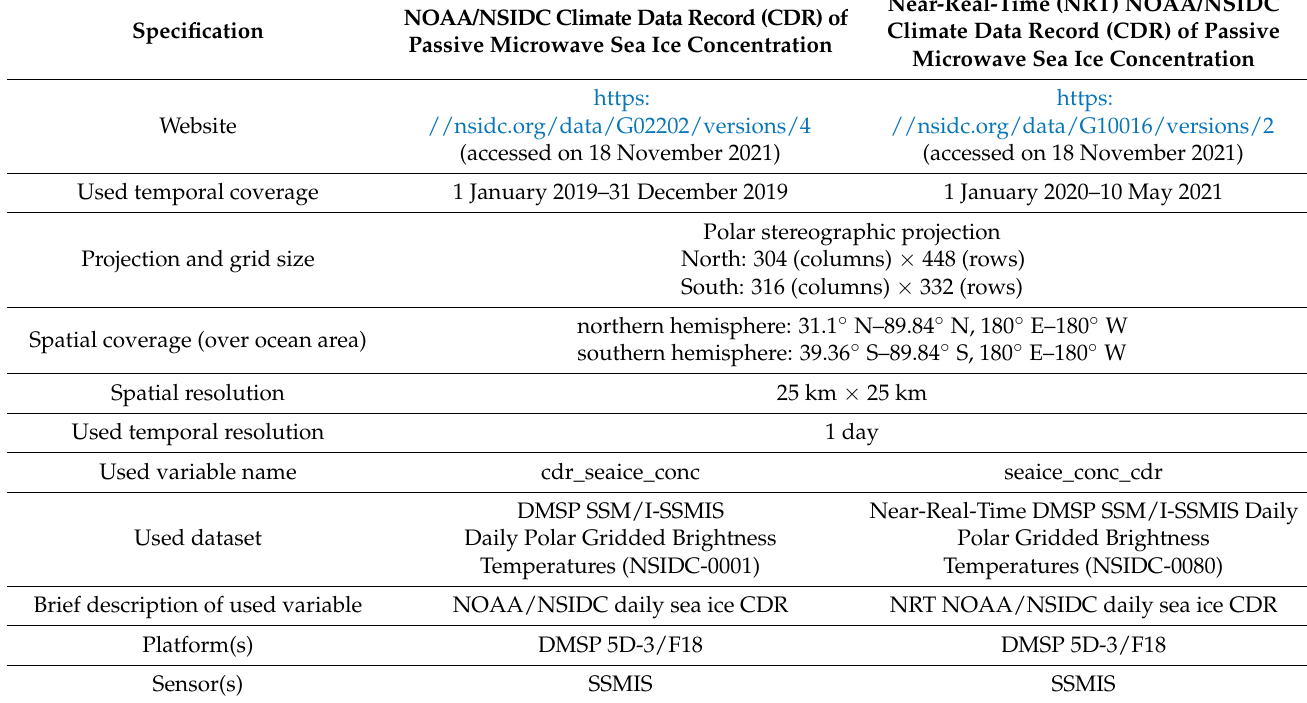
Table 3. The overview of National Oceanic and Atmospheric Administration/National Snow and Ice Data Center (NOAA/NSIDC) climate data record of passive microwave sea ice